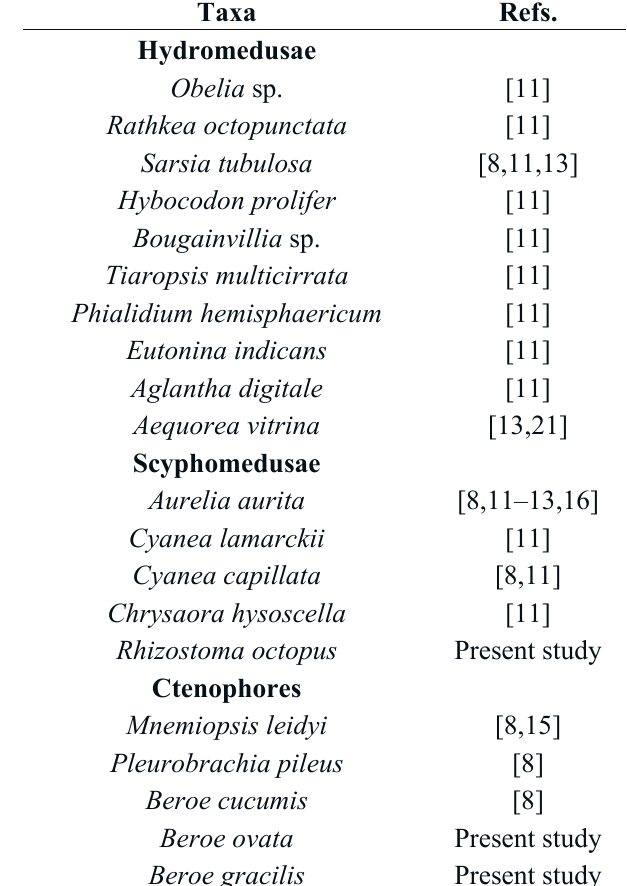
Table 1. Taxa of jellyfish (Hydromedusae and Scyphomedusae) and ctenophores observed in